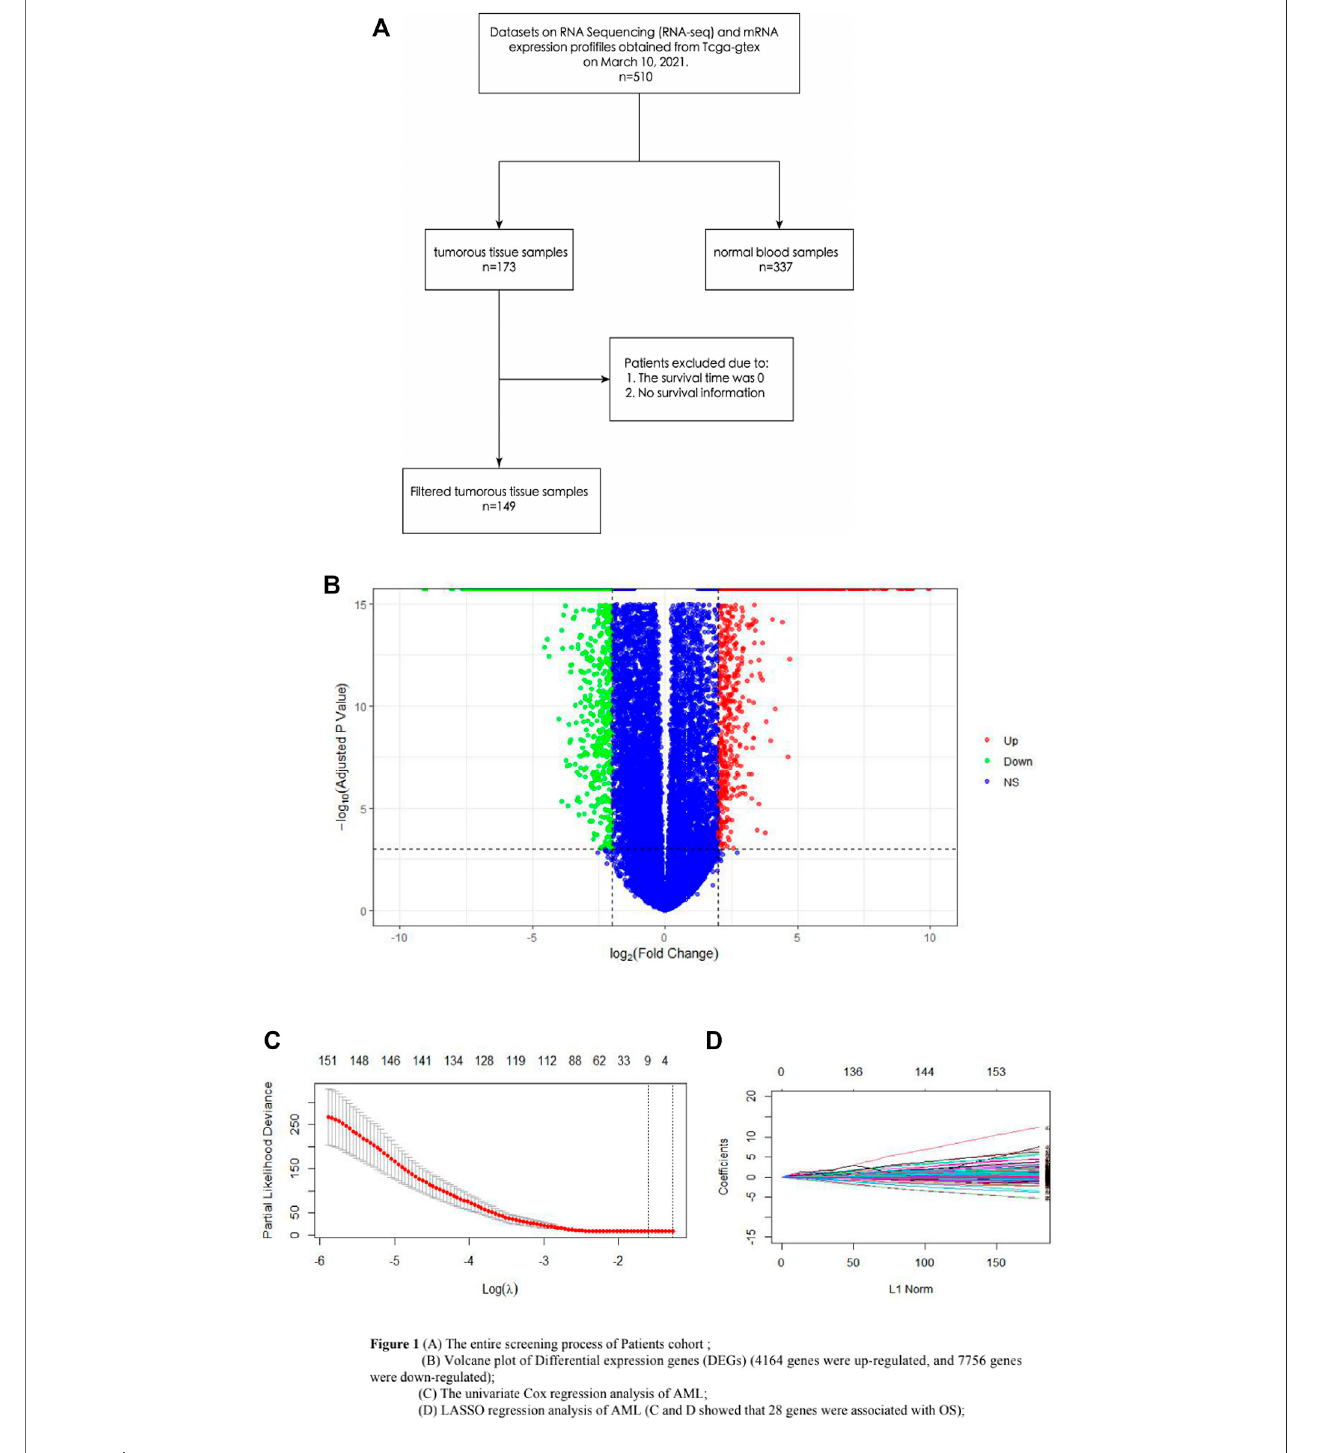
FIGURE1|(A) Entirescreeningprocessofthepatientcohort; (B) volcanoplotofDEGs(4164geneswereupregulated,and7756genesweredownregulated); (C) univariate Cox regression analysis of AML; and (D) LASSO regression analysis of AML. (C,D) show that 28 genes were associated with OS.